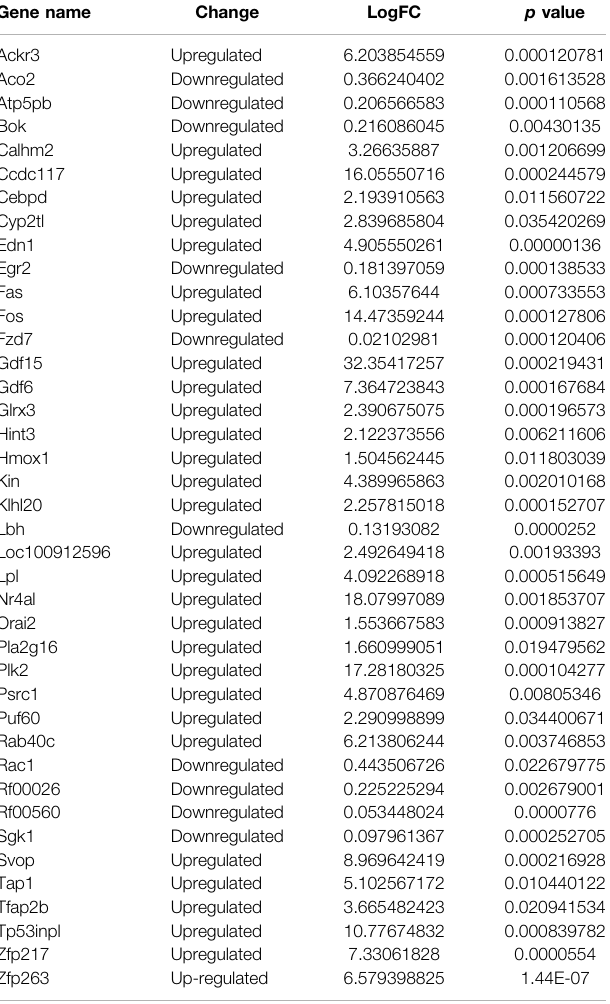
TABLE 1 | Genes differentially expressed 12 and 24 h after x-ray exposure at doses of 5 and 20